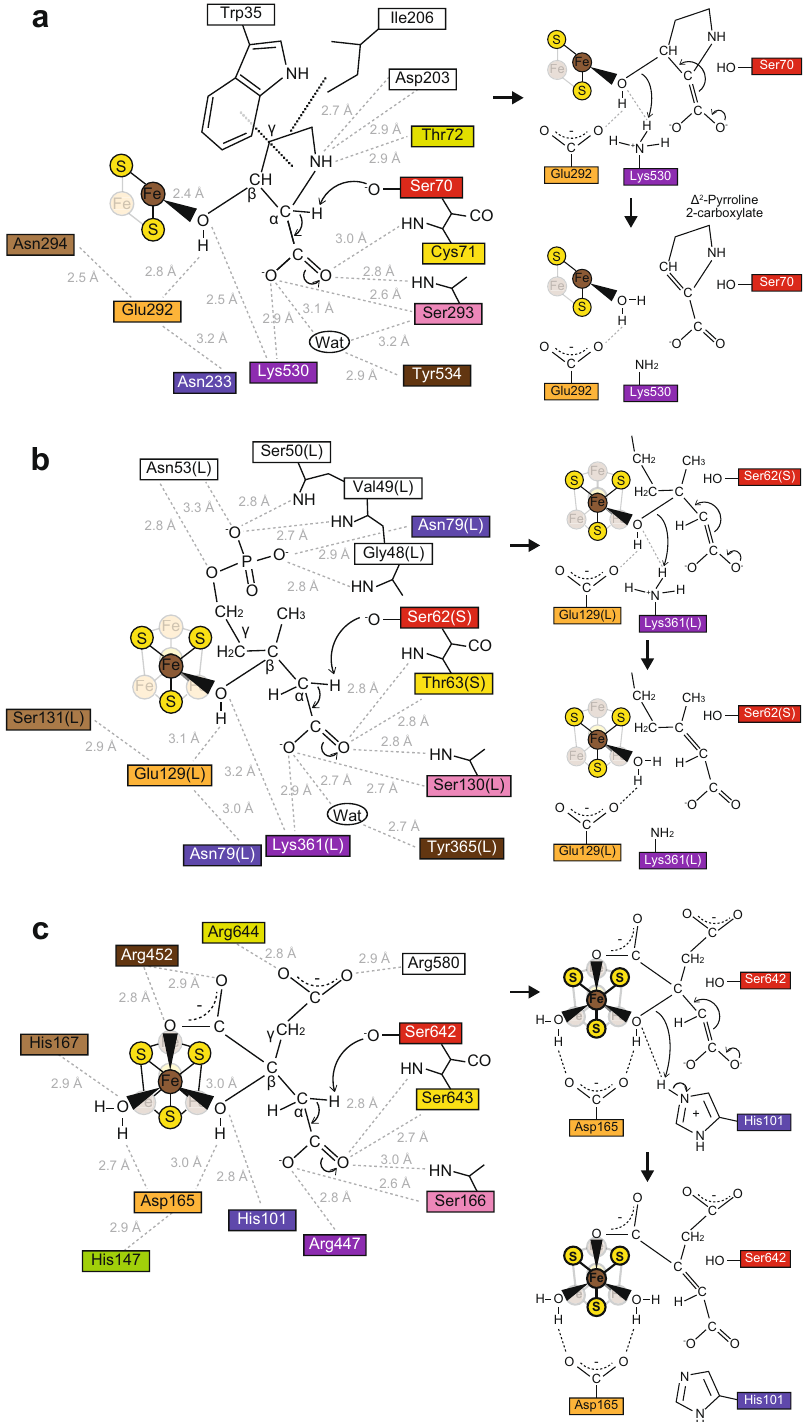
Fig. 7 Putative catalytic mechanism. The left panel shows schematic diagram showing interactions between the substrate and nearby amino-acid residues in AtAcnX ( a ), TkAcnX ( b ), and mAcn ( c ). Amino-acid residues that are located at equivalent (or close) positions are indicated in the same color and correspond to Fig. 2. The light panel shows a schematic representation of the reaction assuming the deprotonation of a serine residue (red) when the substrate binds and Fe-OH 2 is